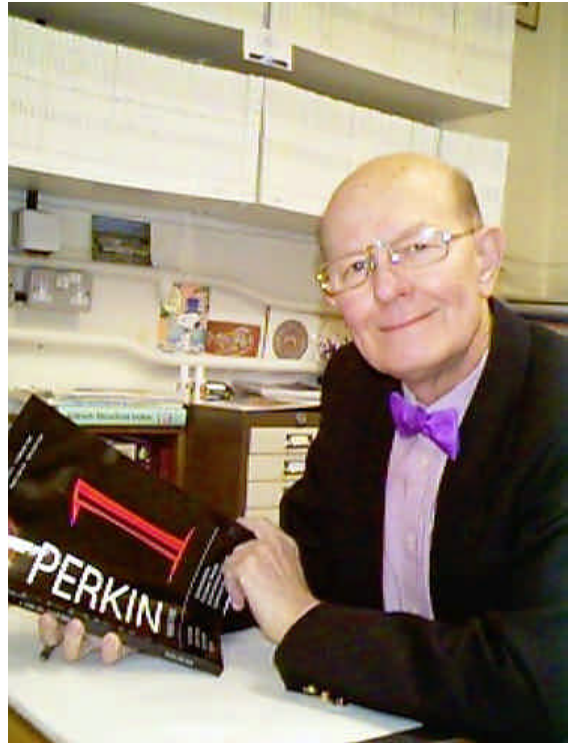
Figure 5. Professor C. W. Rees wearing the "mauveine" bow